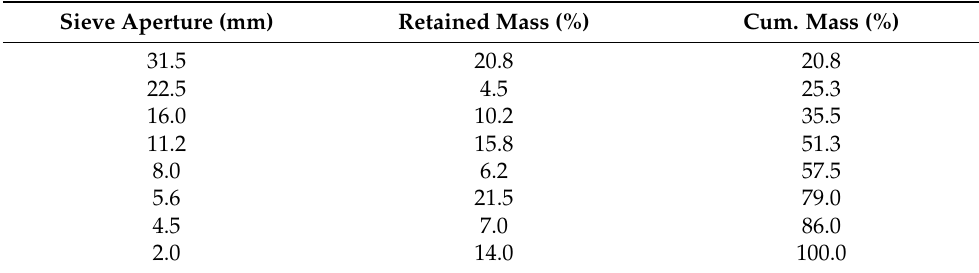
Table 3. Particle size distribution of the bulk sample used in the sink-float studies.